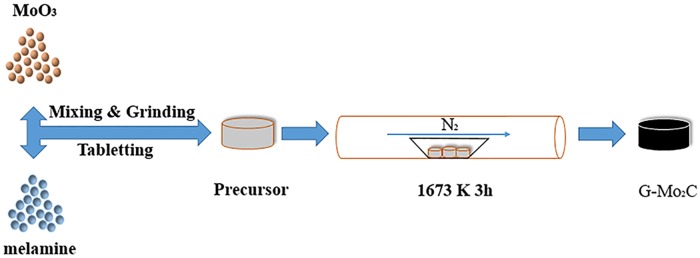
Typical synthesis process of G-Mo2C nanocomposites.